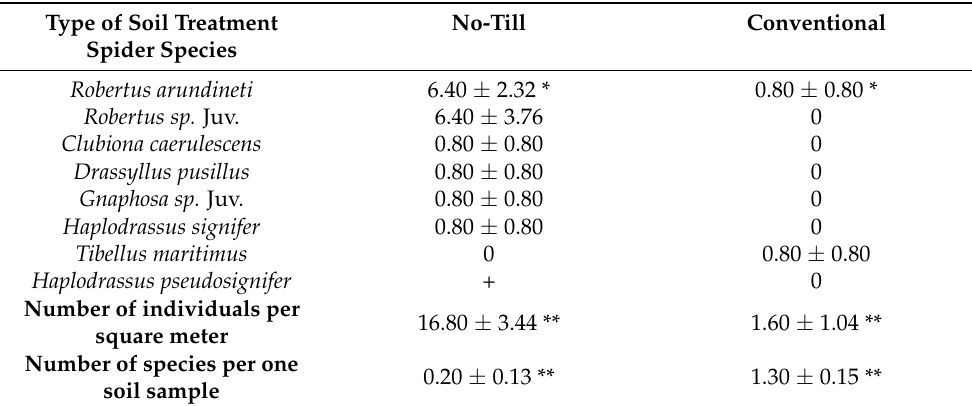
Table 7. Mean numbers and standard errors of the abundance of spiders (Arachnida, Aranei) per square meter (for number of species, per one soil sample) depending on the type of tillage in 2017.